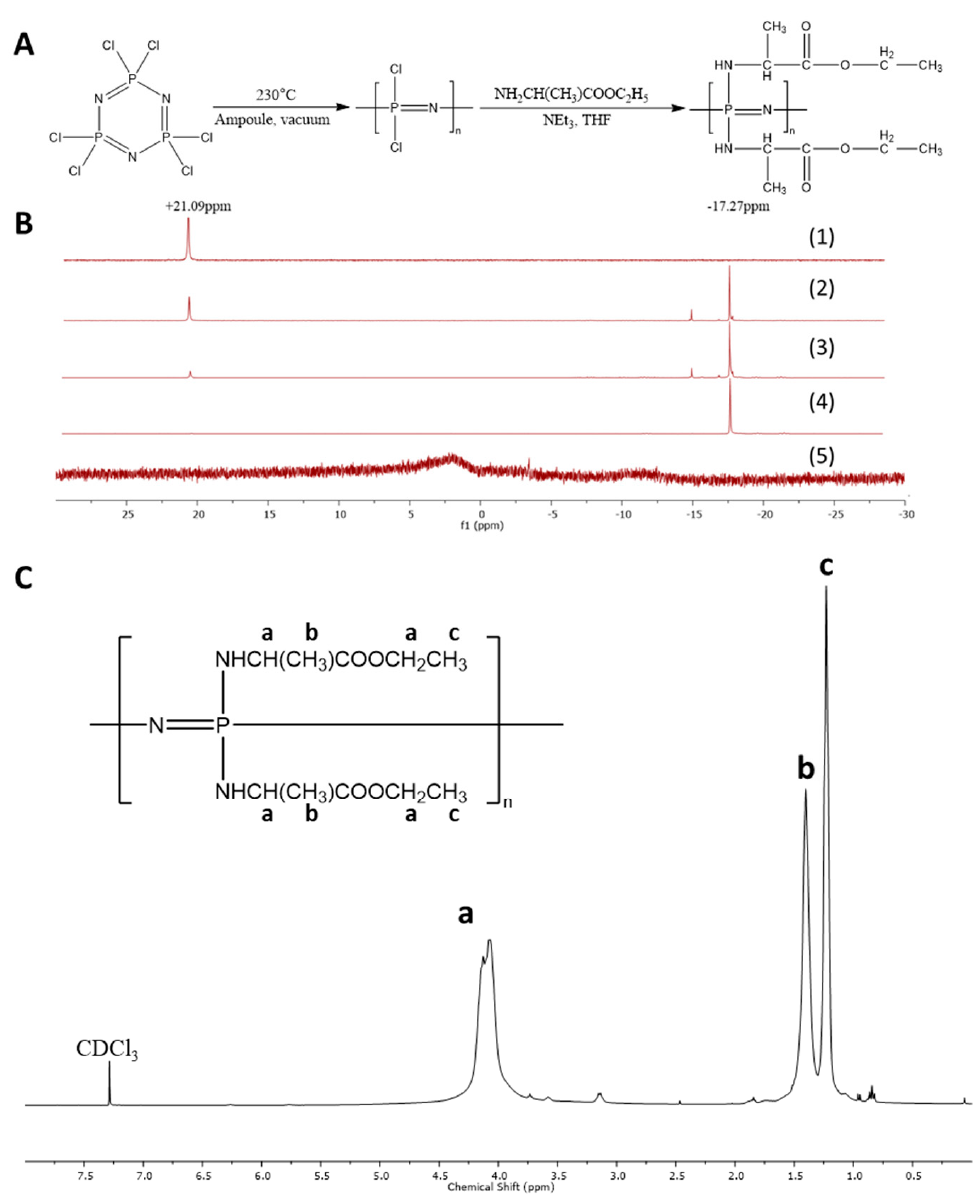
Figure 1. ( A ) Synthesis scheme of P α APz-A. ( B ) 31 P NMR of (1) HCCP, (2) Crude PDCP from GS method, (3) Crude PDCP from FS, and (4) purified PDCP, (5) P α APz-A. ( C ) 1 H NMR of P α APz-A. In the 31 P-NMR spectrum of P α APz, after the macromolecular substitution with alanine ester, the peak at − 17.27 ppm, representing the phosphorous atom on